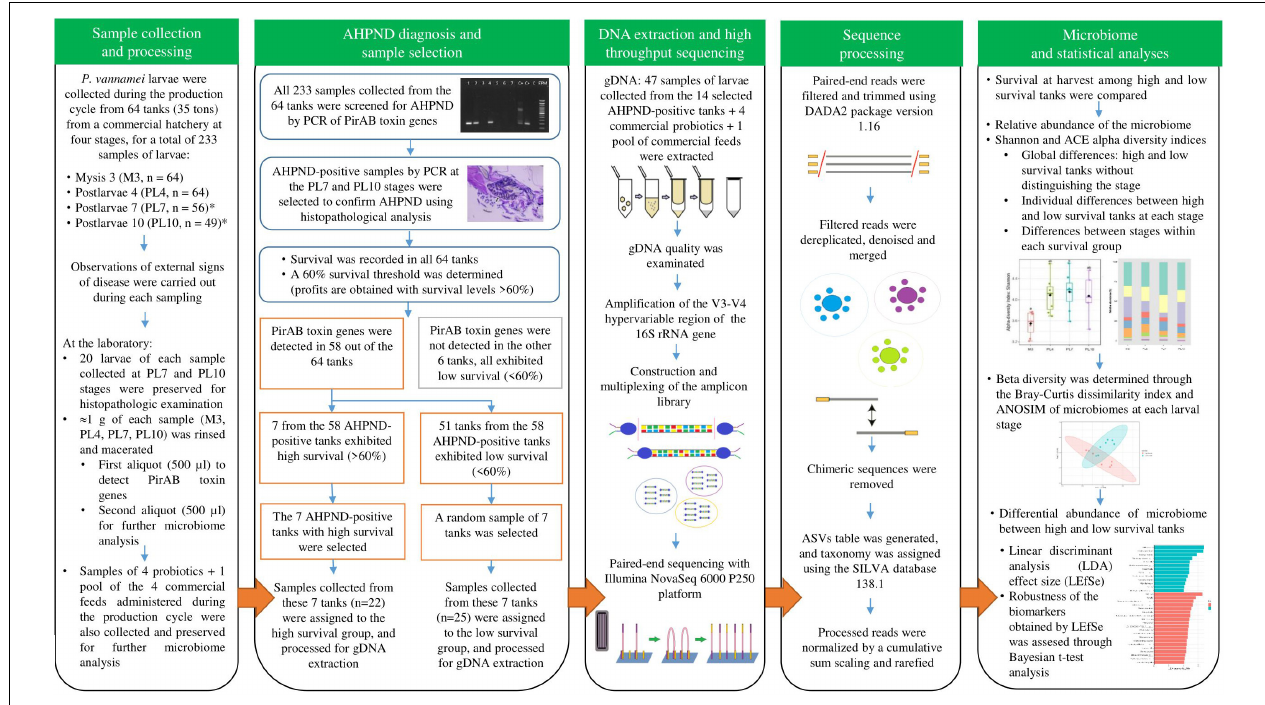
FIGURE 1 | Experimental design for the microbiome characterization of Penaeus vannamei ( P. vannamei ) larvae affected with acute hepatopancreatic necrosis disease (AHPND) and identification of potential biomarkers associated with high and low survival in shrimp hatchery tanks through high-throughput sequencing. ∗ Only 56 and 49 samples were collected at PL7 and PL10 as the population of 8 and 7 tanks died at PL6 and PL9 stages, respectively.